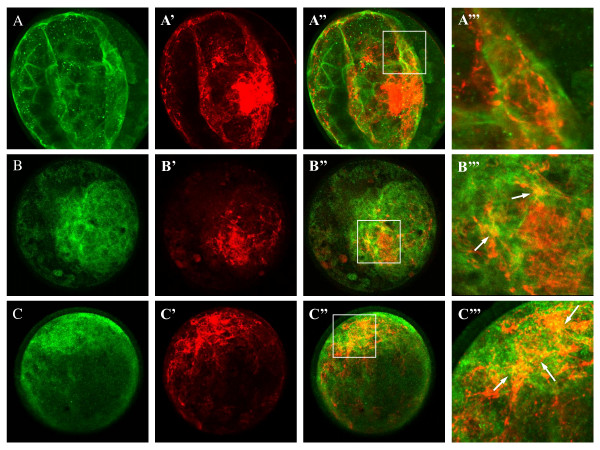
Localisations of the FN1 and integrin subunits by double immunofluorescent staining on in vitro produced blastocyst. (A) Double immunofluorescent staining for ITGA3 (A, FITC), FN1 (A', Cy5) and merged signals (A"). ITGA3 was mainly expressed at the cell membranes of the TE cells. FN1 and ITGA3 were expressed adjacent to each other but no co-localisation was found (A"'). (B) Double immunofluorescent staining for ITGA5 (B, FITC) and FN1 (B', Cy5) and merged signals (B"). (C) Double immunofluorescent staining for ITGAV (C, FITC) and FN1 (C', Cy5) and merged signals (C"). ITGA5 and ITGAV were mainly expressed in the ICM. Partial co-localisation with FN1 was observed for ITGA5 (B"') as well as ITGAV (C"') by the appearance of yellow areas when signals were merged (indicated by arrows) (Original Magnification ×400).